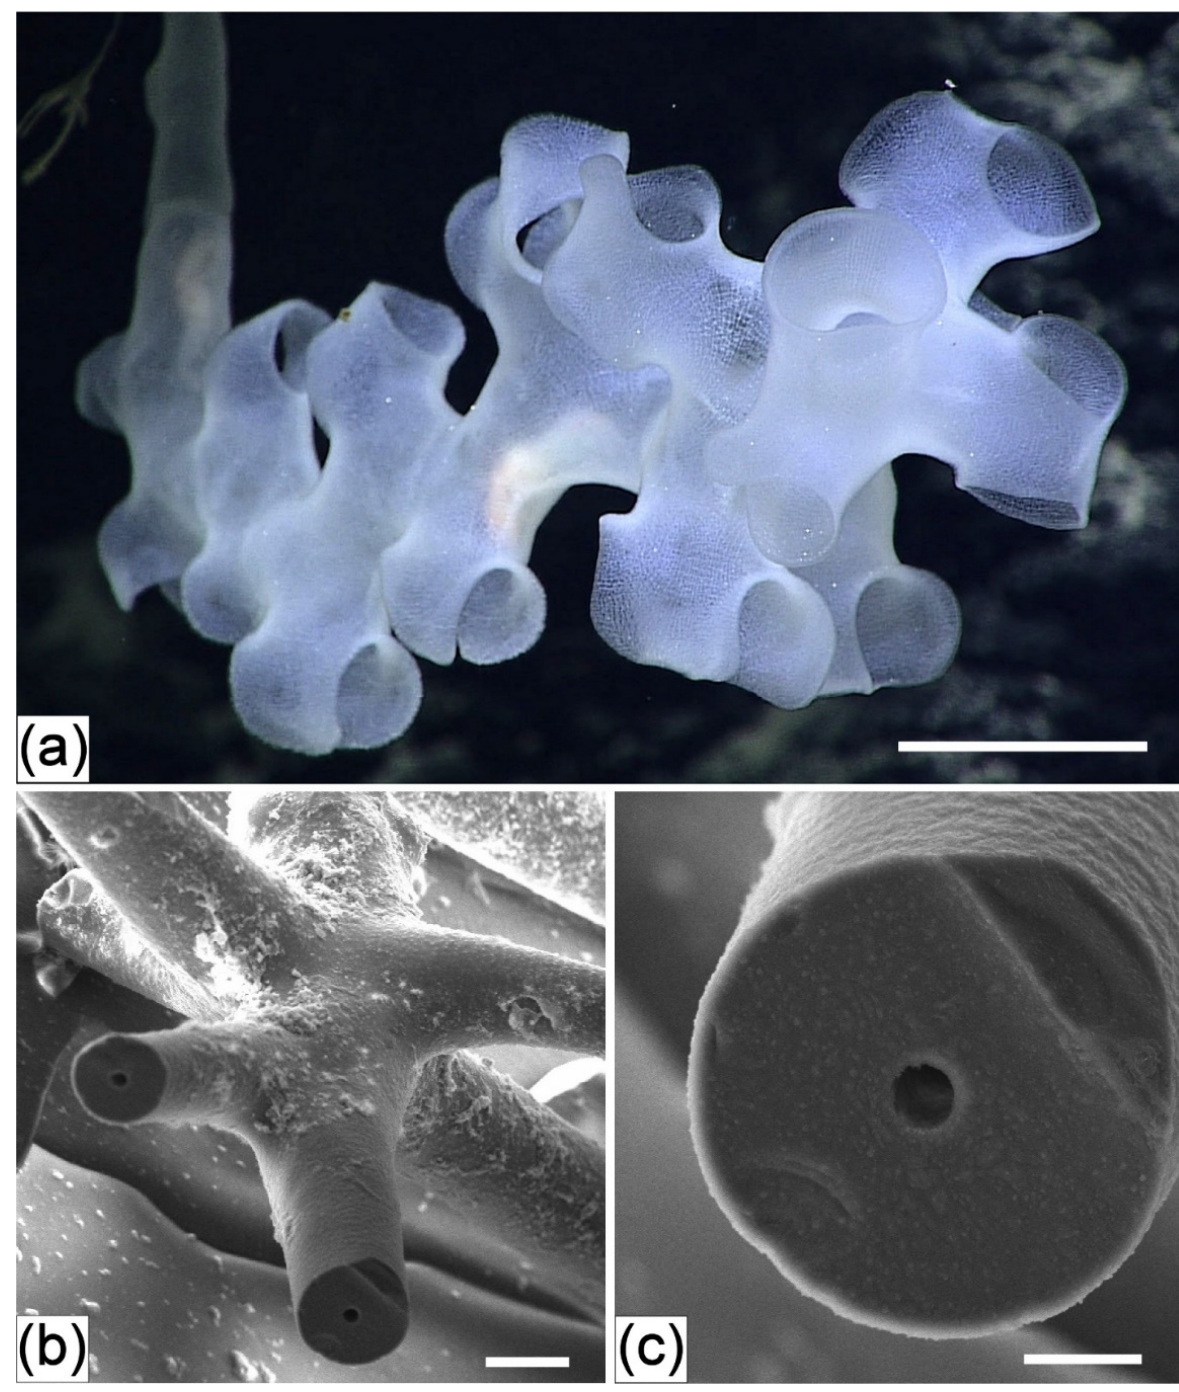
Figure 9. Farrea sp. Morphological feature ( a ) and the ultrastructure of the spicules by SEM ( b , c ). Scale: ( a )—4 cm, ( b )—60 μ , ( с )—20 μ .